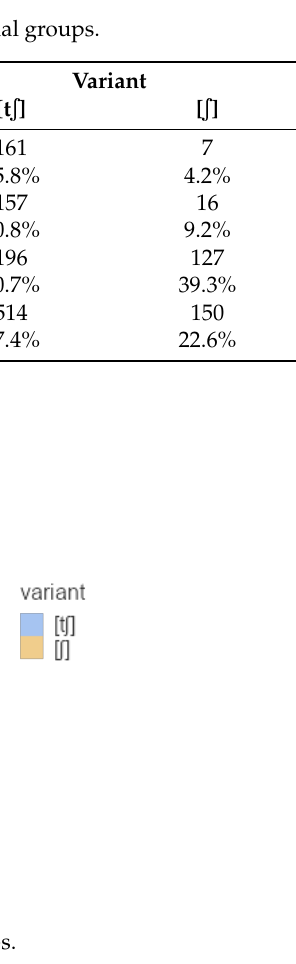
Figure 5. Distribution of [t ʃ ] and [ ʃ ] across